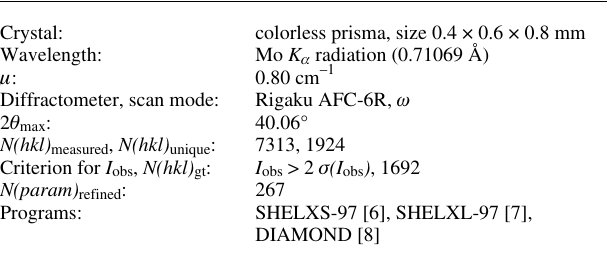
Table 1. Data collection and